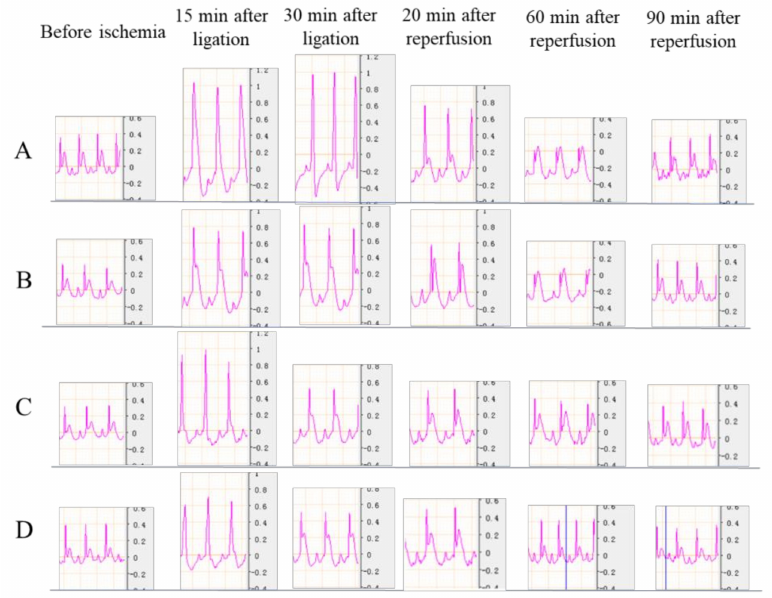
Figure 9. ECGs of rats with myocardial I/R injury in the model group ( A ), resveratrol group ( B ), low-dose 13 group ( C ), and high-dose 13 group ( D